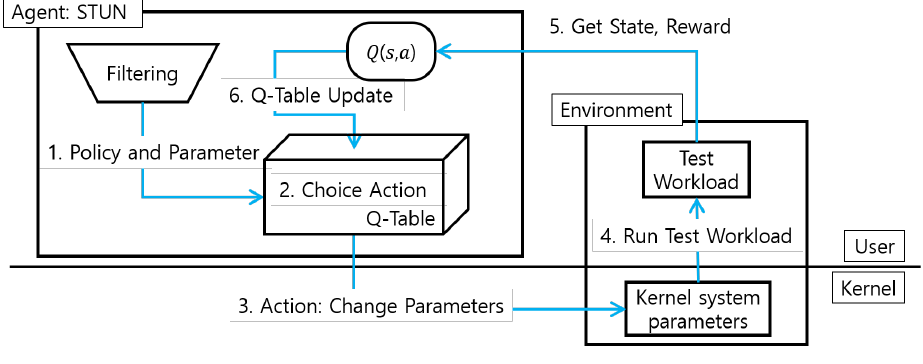
Figure 2. Structure of